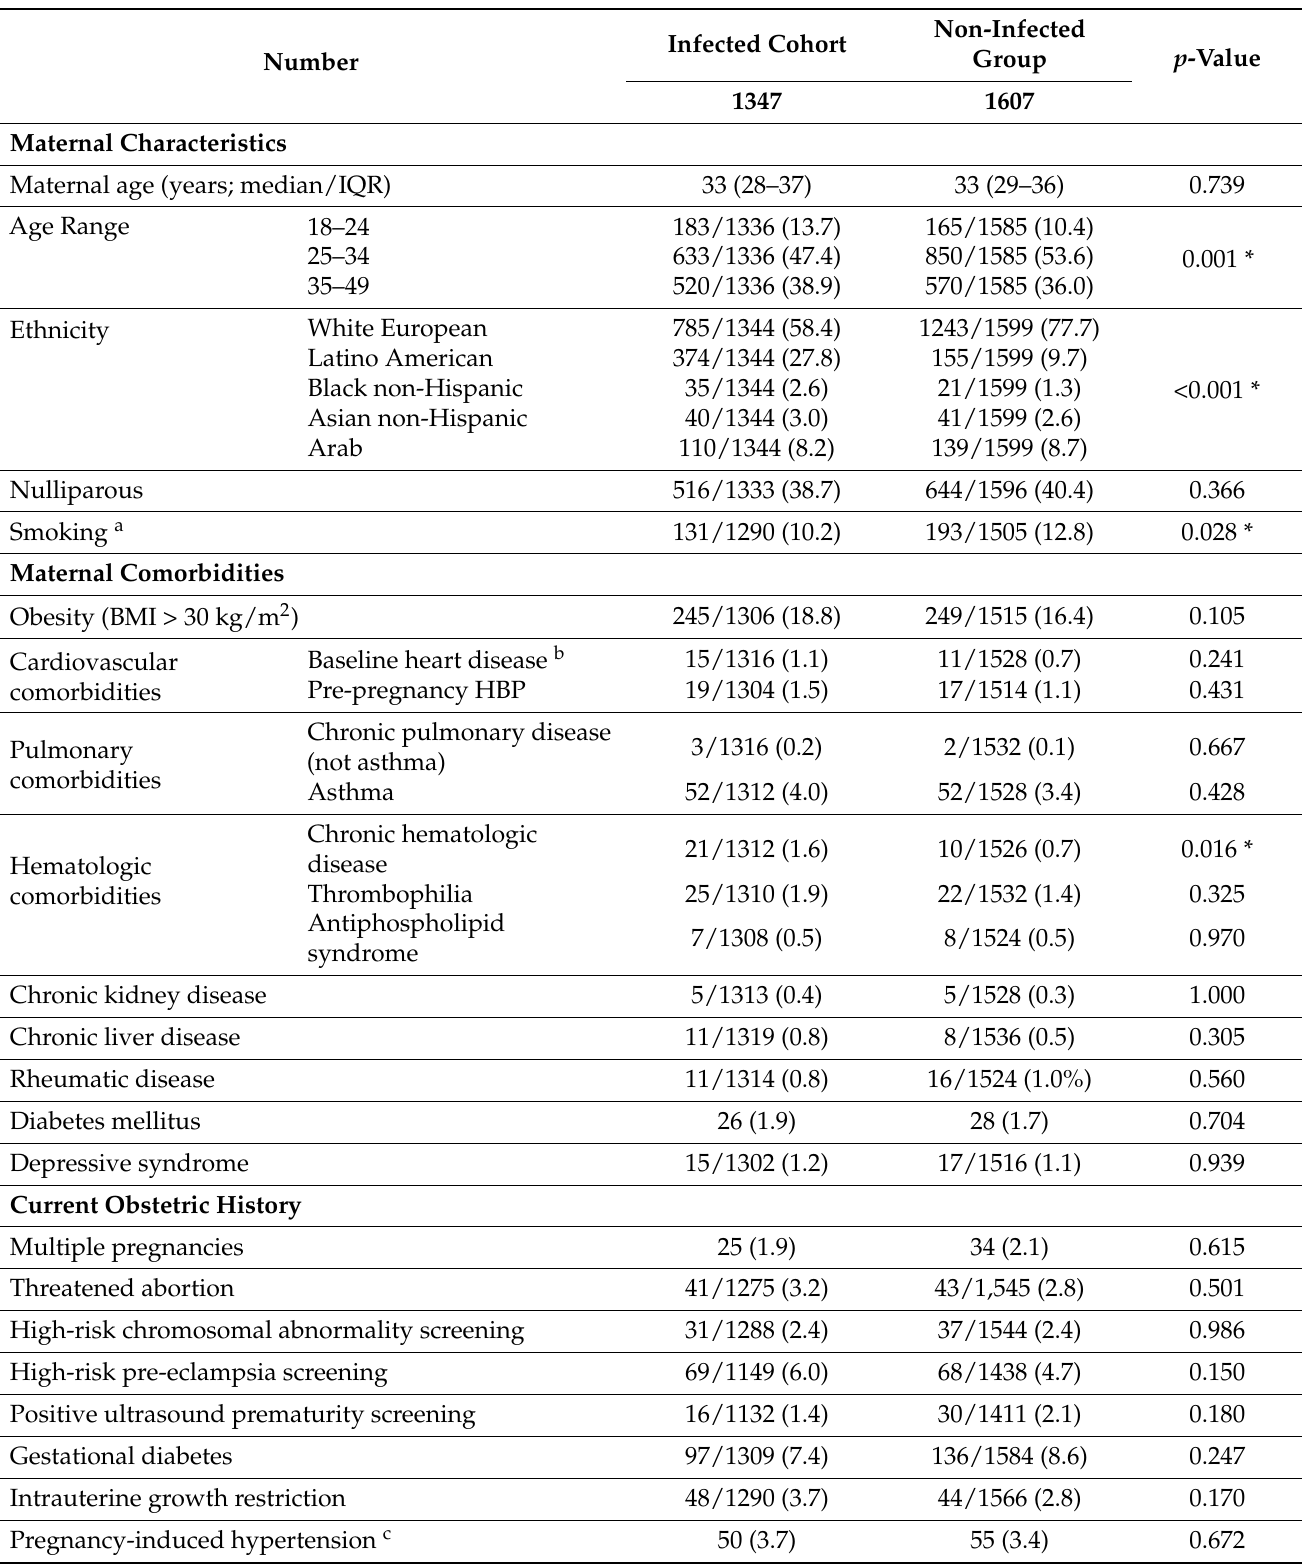
Table 1. Demographic characteristics, comorbidities, and current obstetric history of the study participants ( n =